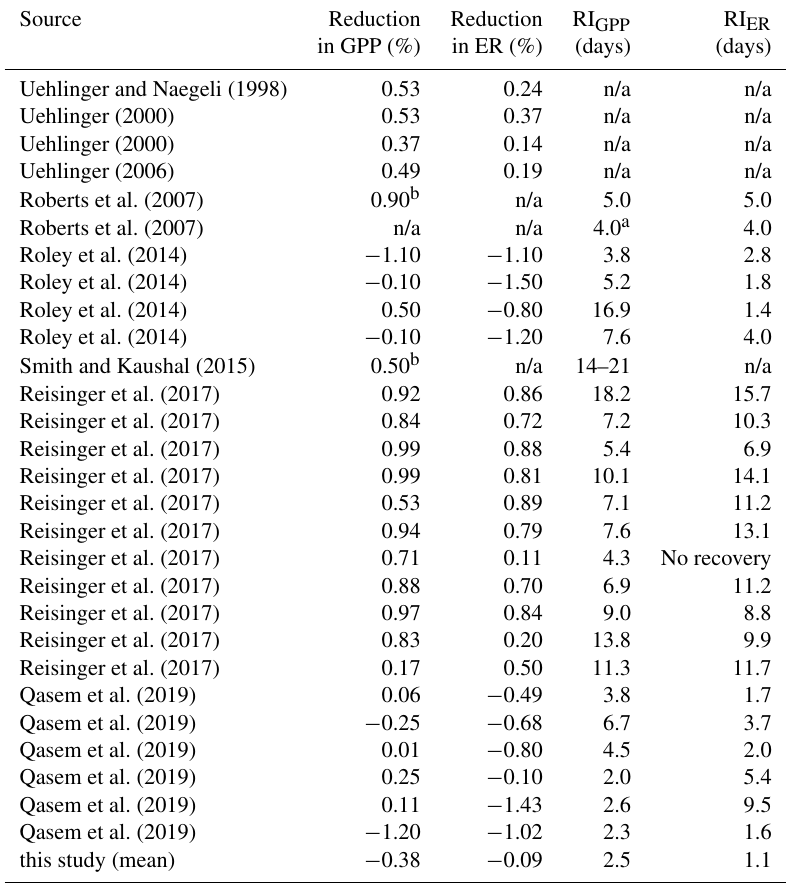
a Approximated days of recovery from figure in publication. b Approximation given in